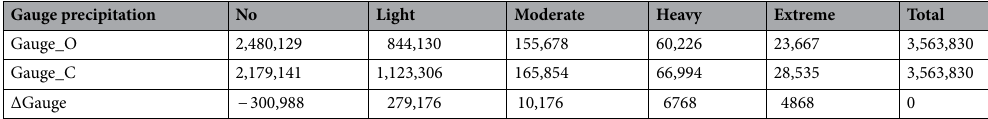
Table 5. Frequency distributions of precipitation events in different precipitation classes from Gauge_O and Gauge_C. ∆Gauge denotes the frequency change for gauge-observed precipitation events after bias correction, which is calculated by frequency distribution from Gauge_C minus that from